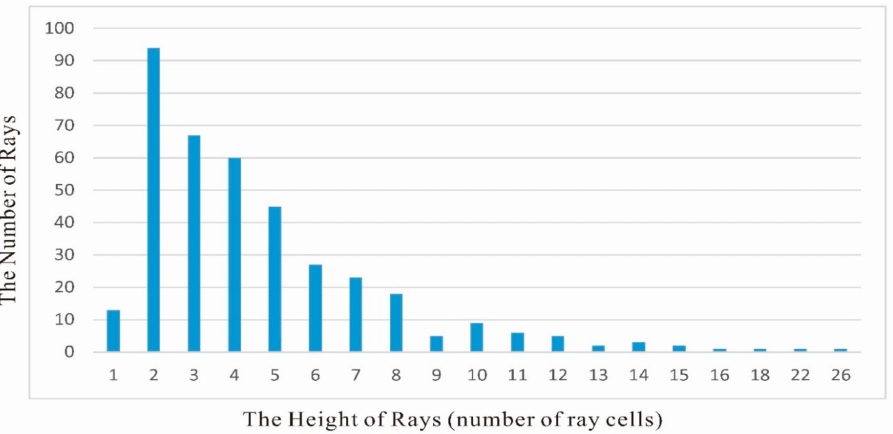
Figure 8. Histogram showing the height-frequency distribution of 790 rays in tangentially longitudi- nal section of